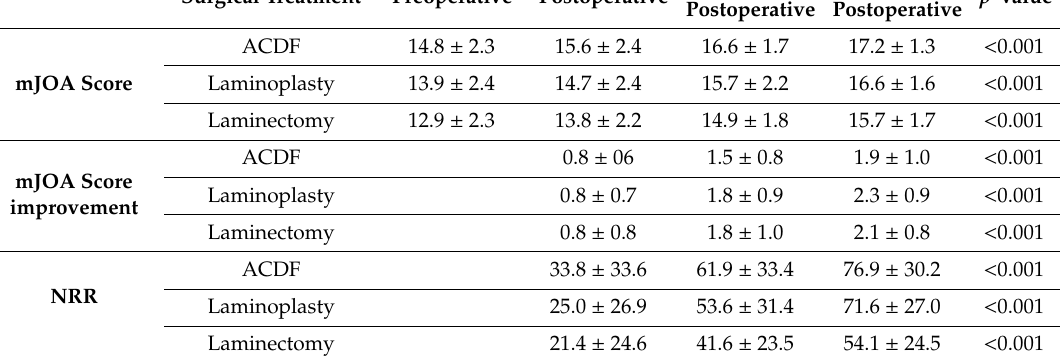
Table 6. Modified Japanese Orthopedic Association Score (mJOA Score), neurological recovery rate (NRR) and the mean mJOA Score improvement according to the surgical treatment; anterior cervical discectomy and fusion: